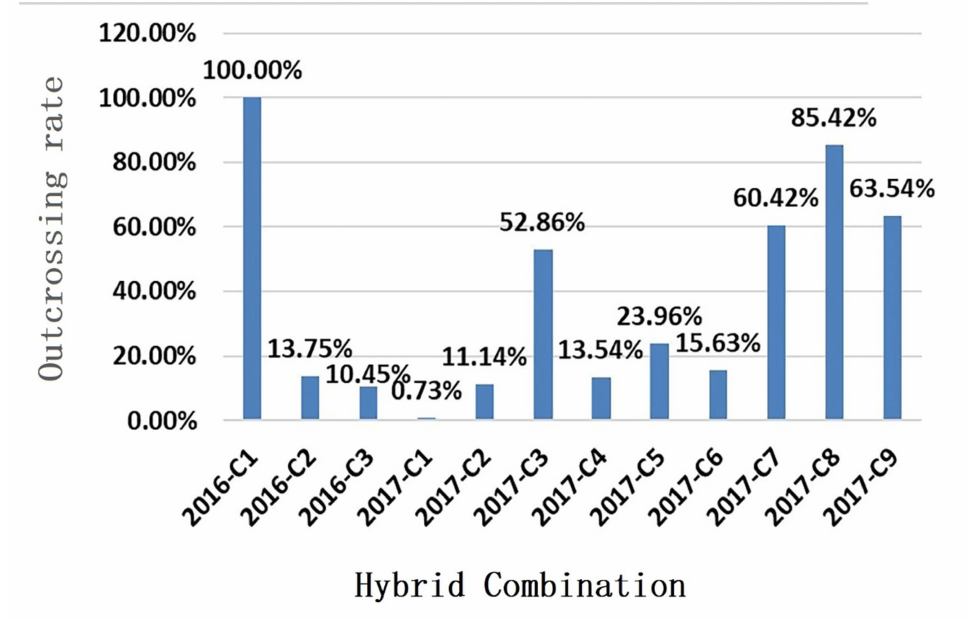
Figure 5. Outcrossing rate of each combination at 30 days after pollination in 2016 and